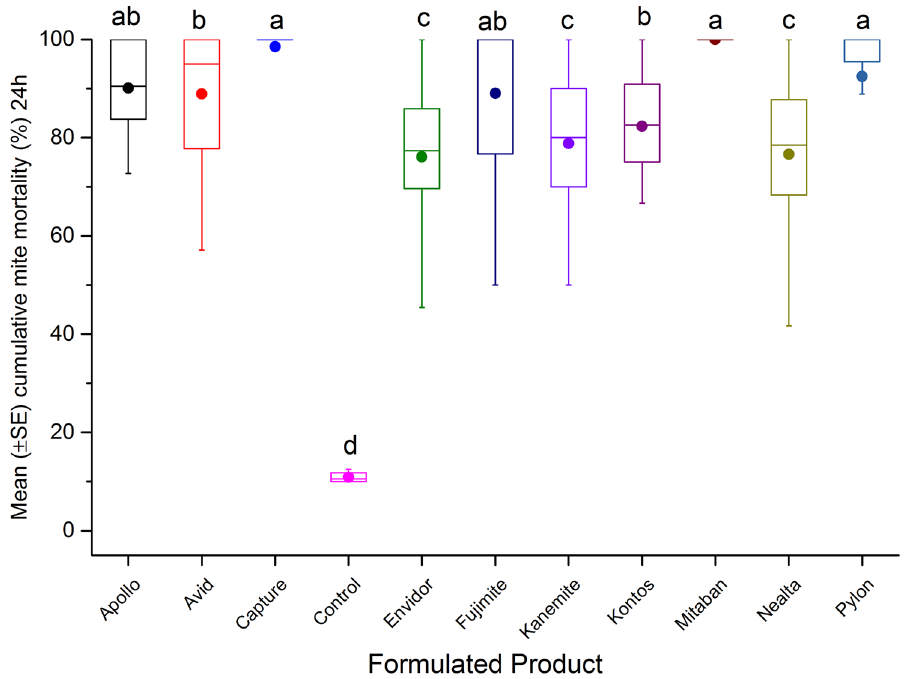
Figure 4. Mean (± SE) cumulative mite mortality (%) during 24 h exposure to different dilutions (0.1 mgL −1 , 1 mgL −1 , 10 mgL −1 , 100 mgL −1 , 1000 mgL −1 , or 10,000 mgL −1 ) of tested FPs in acute surface contact toxicity assay using 20 mL borosilicate glass scintillation vials. A group of mites was treated with different dilutions of Mitaban as reference control, or left untreated (control) as negative control. The boxplots present the standard error (length of box), mean (solid circle), median (horizontal line), 5th and 95th percentiles (lower and upper vertical lines). Each box indicates average mortality for replications of each FP (n = 24) or control (n = 4). Means with the same letter among treatments are not significantly different ( p >